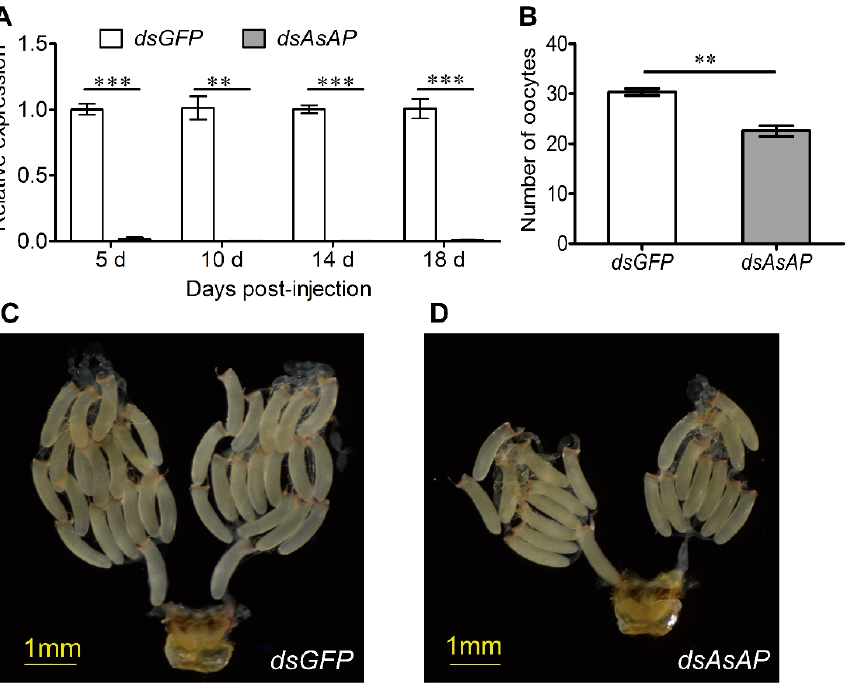
Figure 4. AsAP knockdown suppressed ovarian development. Newly emerged females were micro- injected with dsAsAP or dsGFP (control): ( A ) the AsAP transcript levels at 5, 10, 14 and 18 days post-injection; ( B ) the number of oocytes per ovary pair; ( C ) the ovaries from females that were injected with dsGFP ; ( D ) the ovaries from females that were injected with dsAsAP . ( C , D ) were imaged at 10 days post-injection using a stereo microscope. All values are expressed as means ± SEM, based on three independent biological replicates. Asterisks indicate statistical significance (** p < 0.01 and *** p < 0.001, according to Student’s t